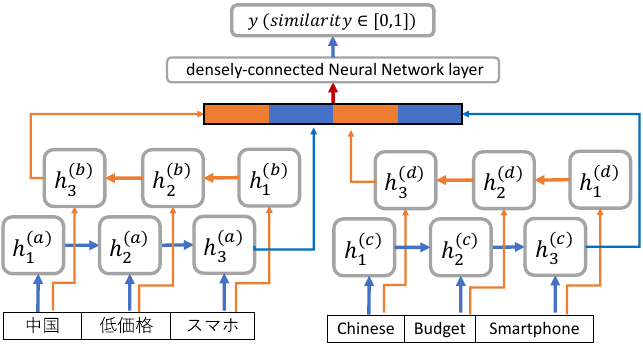
Figure 2. Illustration of the LSTM-based